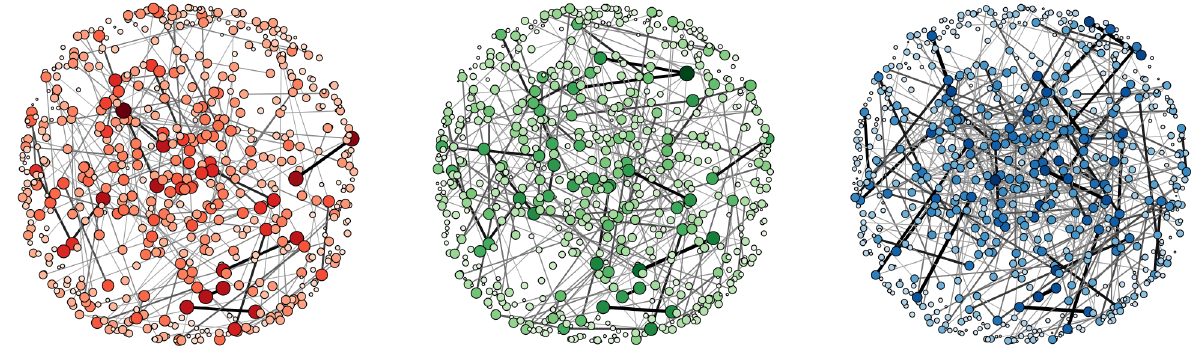
Fig 1. The phone call, the text message, and the proximity networks. The size of a node is determined by the sum of the weights of in-going links. The width and the darkness of a link is given by the square root of the link weight. For visual clarity, we show the nodes in the same positions in each panel and we do not show the weakest links ( w ij <